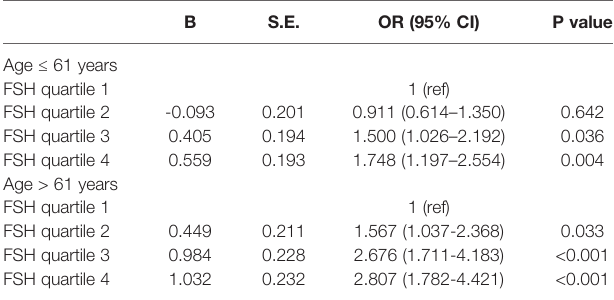
TABLE 5 | Logistic stepwise regression of FSH quartiles for the presence of declined eGFR in postmenopausal women strati fi ed by median age. B S.E. OR (95% CI) P